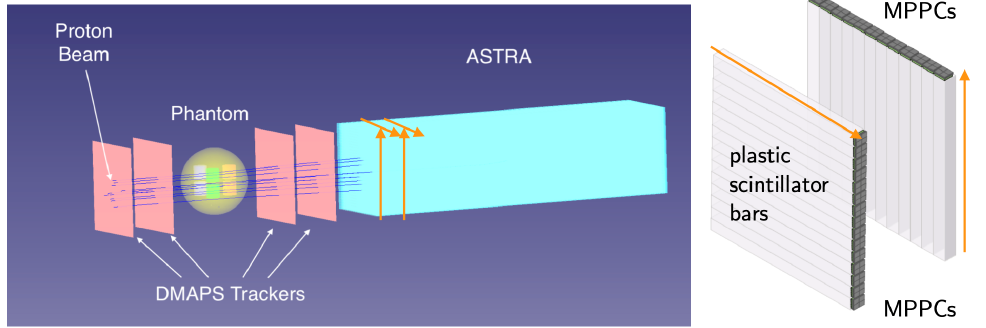
Figure 1. ( Left ): Sketch of the simulated pCT system, including a front tracker made up of four DMAPS and a proton energy tagger named ASTRA. ( Right ): Detailed view of two exploded layers of ASTRA showing the relative orientation of bars in consecutive layers and the placement of multi photon pixel counters